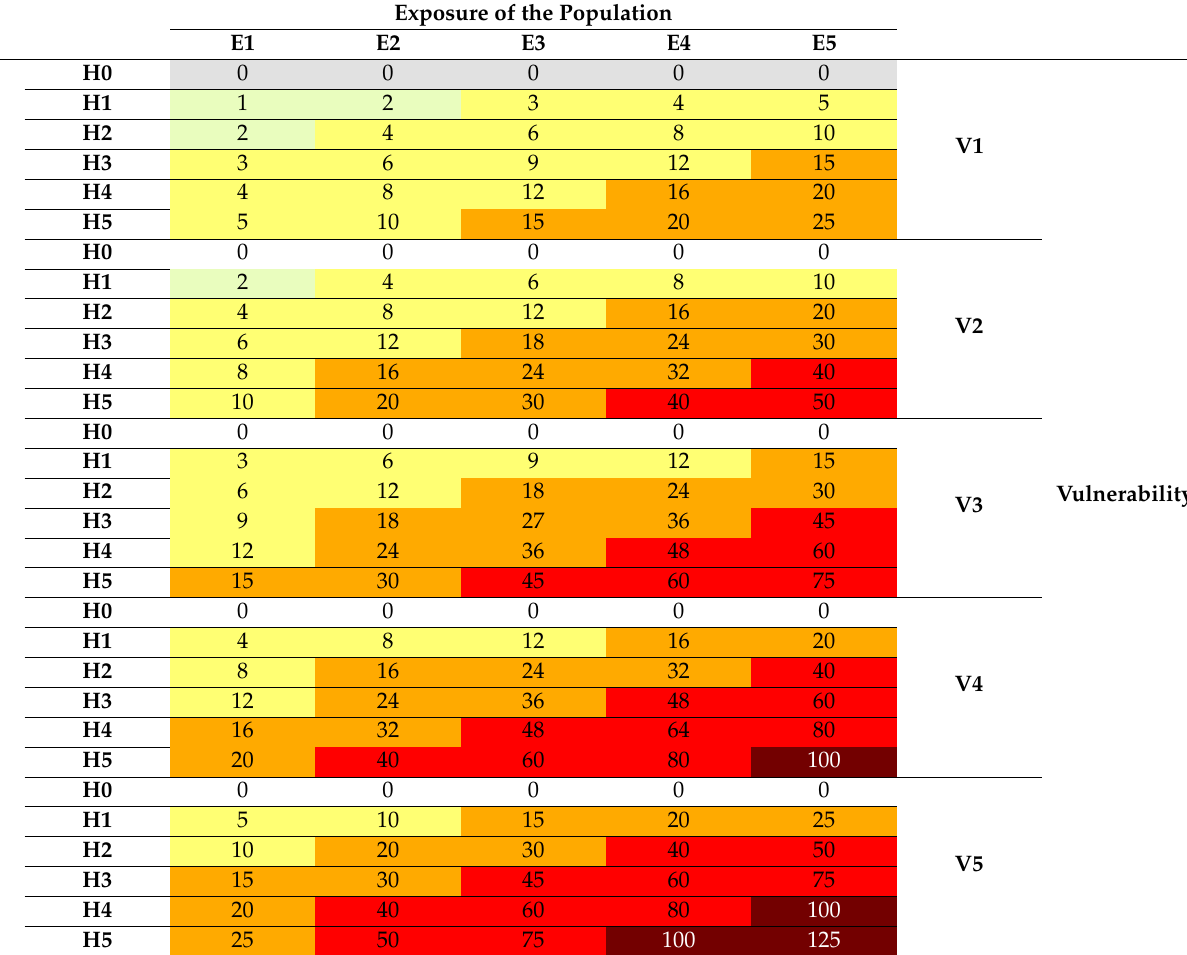
Table 4. Matrix of potential